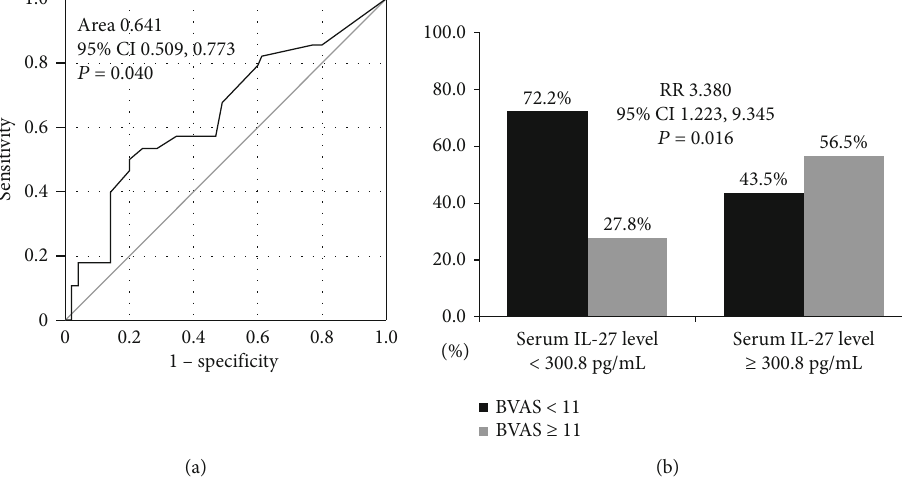
Valuesare expressed as a mean ± standarddeviation . IL: interleukin;BVAS: Birminghamvasculitis activity score; N/A: not applicable. ∗ Since only three patients presented mucous and ocular manifestation, statistical analysis is not reliable. ∗∗ Since only one patients presented gastrointestinal manifestation, statistical analysis is not allowed.